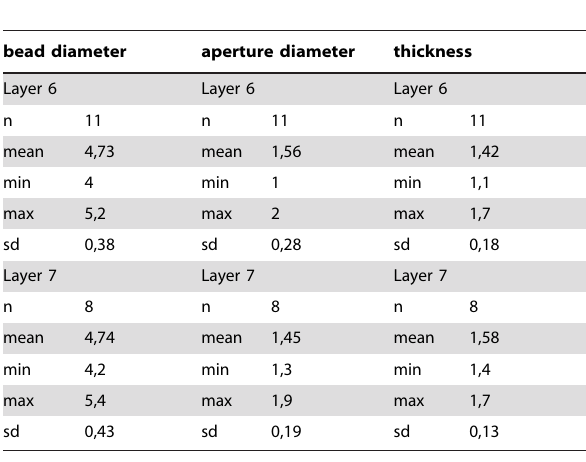
Table 1. External and aperture diameters, and thickness of finished beads of Leopard cave (in